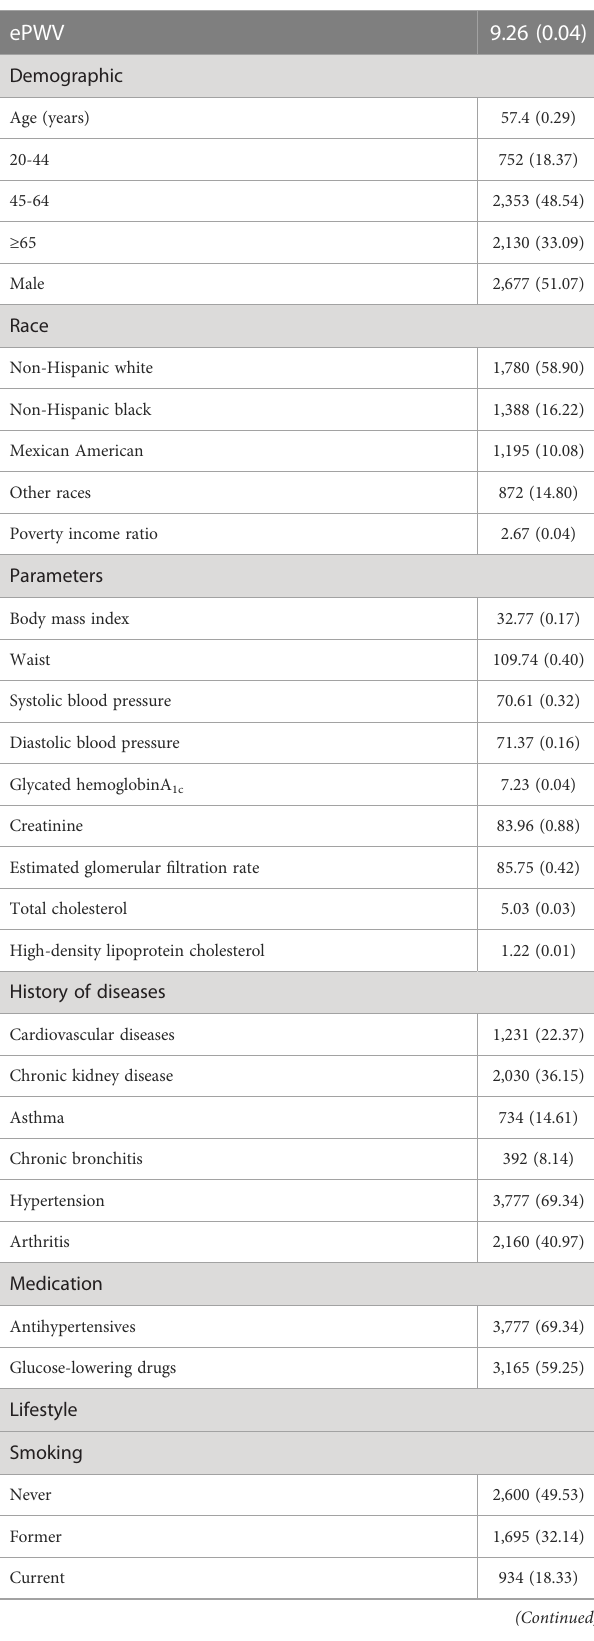
TABLE 1 Survey-weighted baseline characteristics of the diabetic population from NHANES 1999 to 2014 (N=5,235, representing 19,472,771